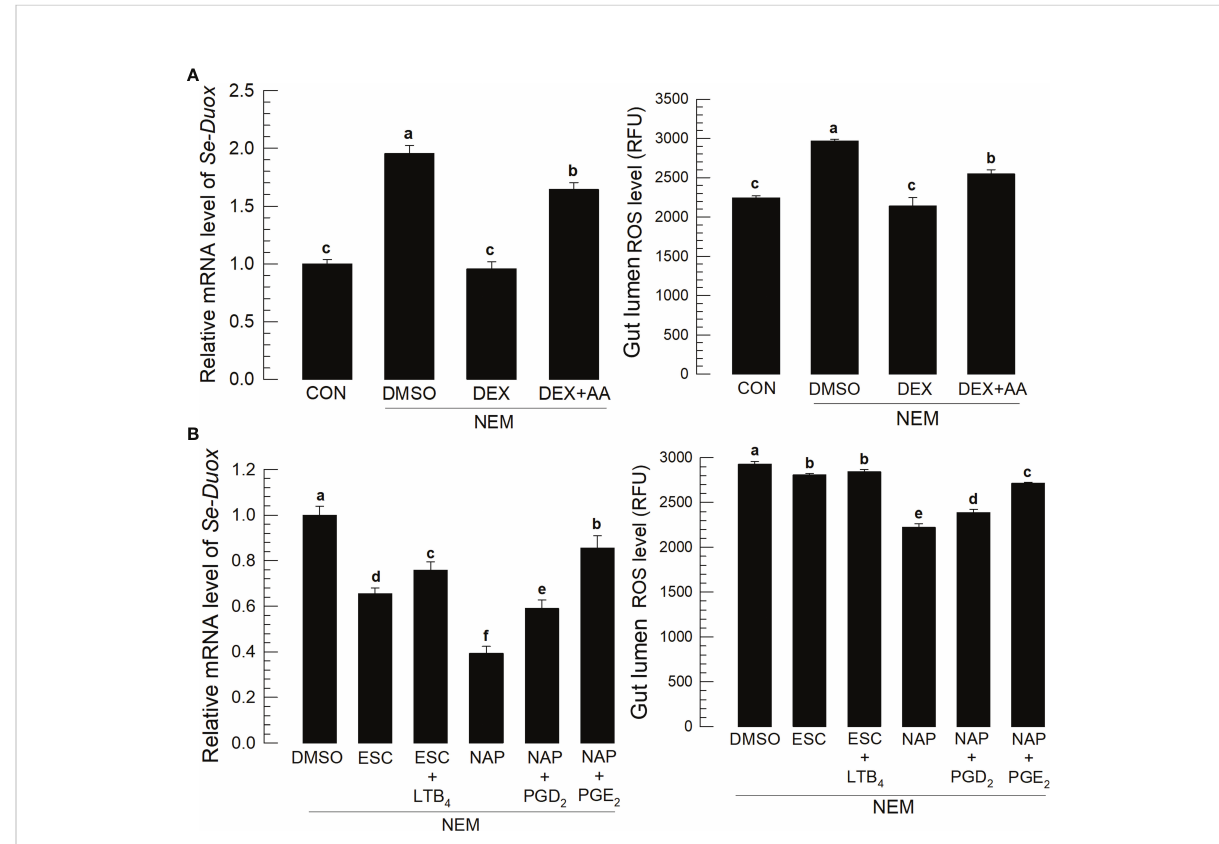
FIGURE 3 Effects of eicosanoids on expression levels of Se-Duox and ROS production in response to gut infection by the entomopathogenic nematode ( ‘ NEM ’ ). Each L5 larva of S . exigua was fed with 80 IJs of S . feltiae . (A) Inhibitory effect of a PLA 2 inhibitor, dexamethasone ( ‘ DEX ’ ), on Se-Duox expression and ROS level in the gut lumen of L5 larvae. NEM treatment was performed 8 h post-injection (PI) of DEX (10 µg/larva) or arachidonic acid (AA, 10 µg/larva). At 8 h after NEM treatment, Se-Duox expression and ROS level were measured. (B) Effect of naproxene ( ‘ NAP ’ , a COX inhibitor) and esculetin ( ‘ ESC ’ , a LOX inhibitor) on the expression of Se-Duox and ROS level. To rescue the inhibitor treatments,